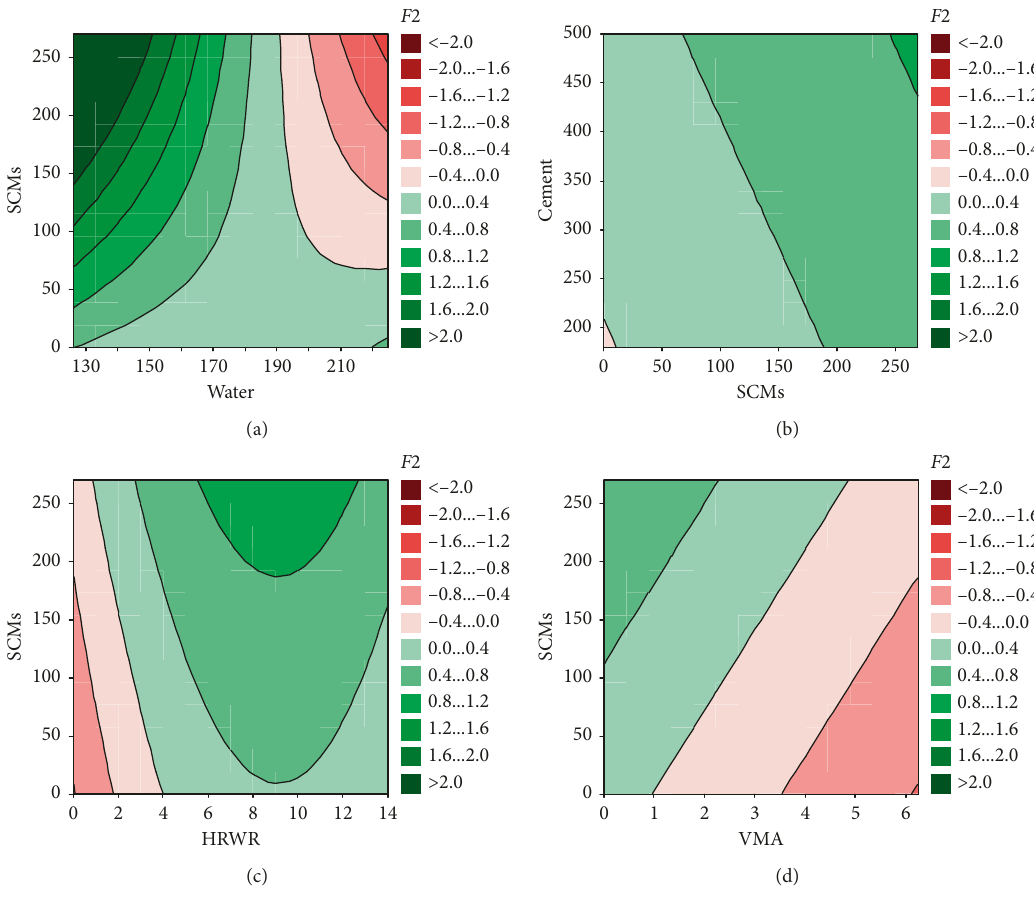
Figure 5: Effect of the paste composition on the flow spread ( F